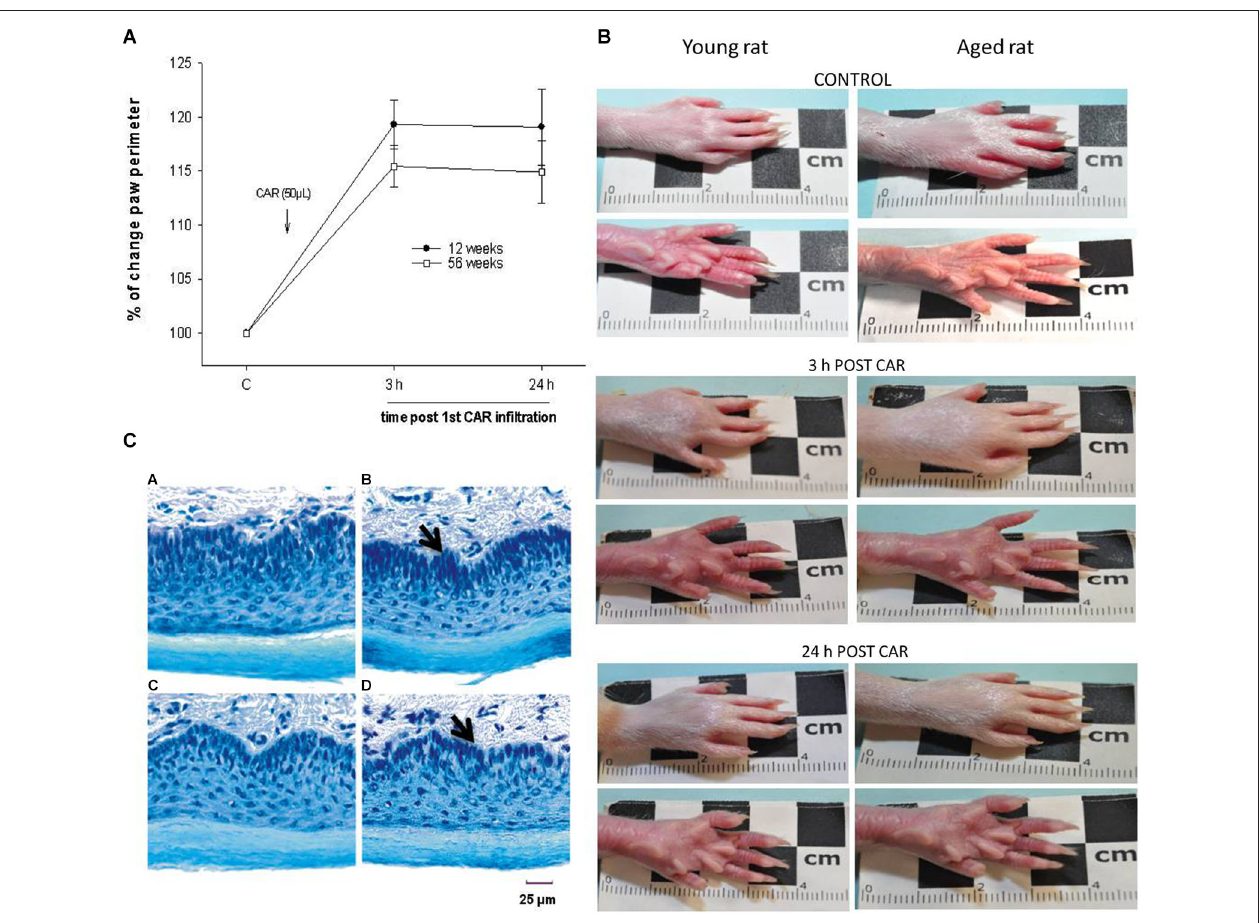
rat paws (15 µ m thick), using the Nissl technique. The figure shows the similarities in paw cytoarchitecture of young (panel C , A), CAR-infiltrated young (panel C , B), aged (panel C , C) and CAR-infiltrated aged (panel C , D) rats. CAR injection was applied into the right paw. Notice the epidermal layer in the bottom of each photomicrography. Panel C , B and D show a compression of the internal dermal layer related to the inflamed connective tissue (arrow). Of relevance are the preservation of the dimensions of the layers and the